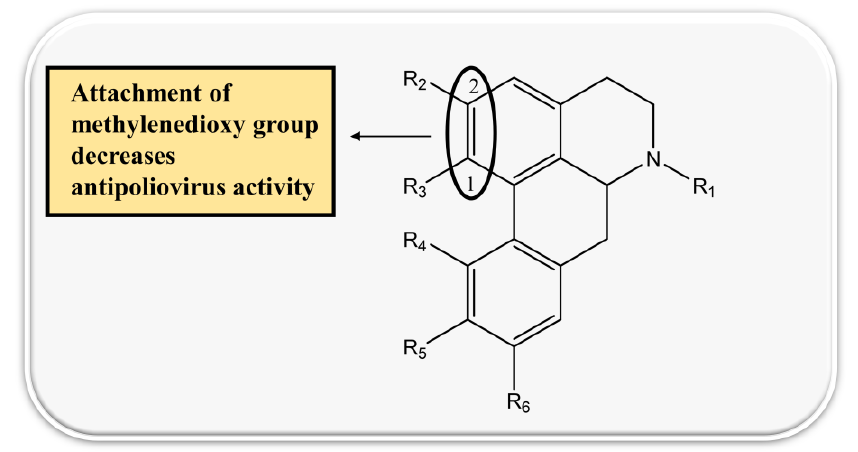
Figure 4. Structure – activity relationship of aporphine